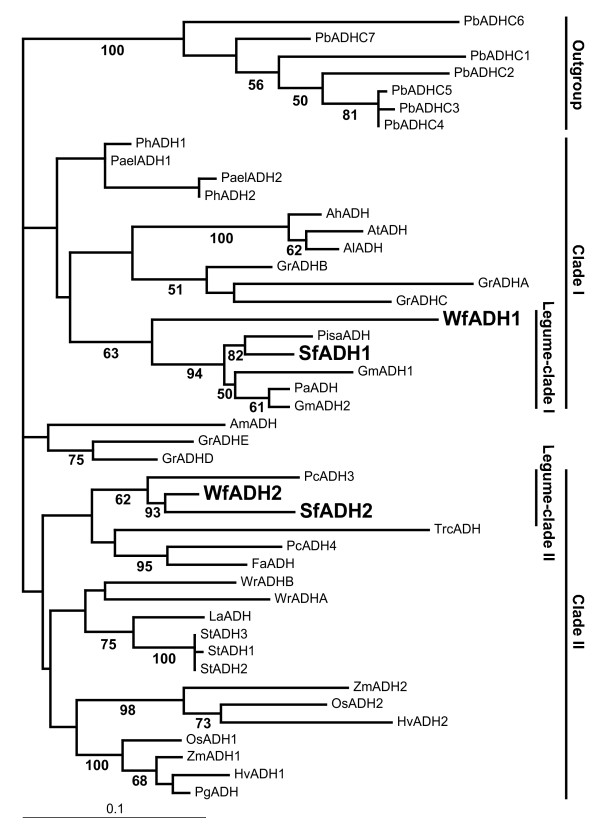
The phylogenetic tree based on Adh gene sequences obtained by the maximum-likelihood method. The log-likelihood of the best ML tree is -3981.05. The numbers below the branches are the bootstrap values of 50% or more support. The Adh genes from legumes roughly fall into two monophyletic clades that we denoted as Clade I and Clade II.